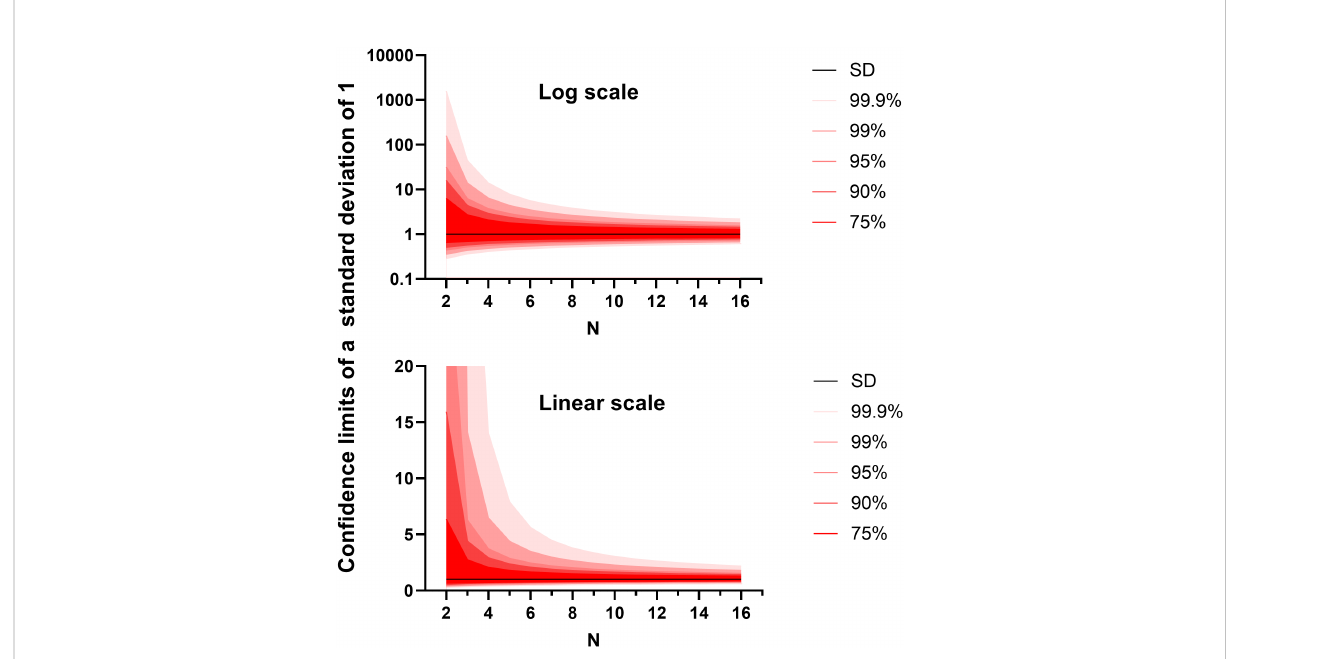
FIGURE 3 The con fi dence intervals for the standard deviation (set to a value of 1) generated from different sample sizes. The graphs were generated using Graphpad PRISM V8.0 (San Diego), using the ‘ xy plot ’ function using single values for y. The density function was used. Data were generated from fi rst principles using Equation 3.5 on page 217 from the Handbook of Parametric and Nonparametric Statistical Procedures (Shedskin 2011). Above shows the relationship on a logarithmic scale and below shows the relationship on a linear